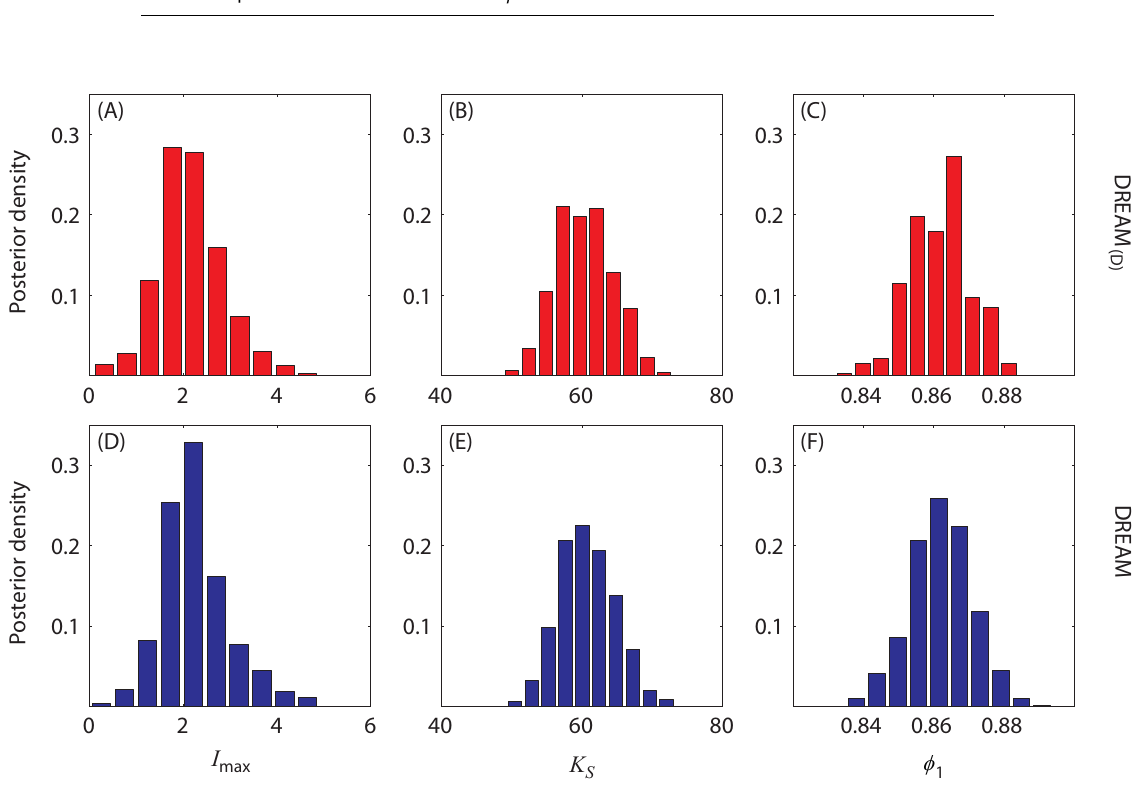
Fig. 7. Histogram of the DREAM ( D ) derived marginal posterior distributions of the (A) I max , (B) K S , and (C) φ 1 rainfall – runoff and error model parameters (in red). For convenience, only a few parameters are plotted. To benchmark the results of DREAM ( D ) the bottom panel illustrates the results for DREAM (in blue), with the common assumption of a continuous parameter